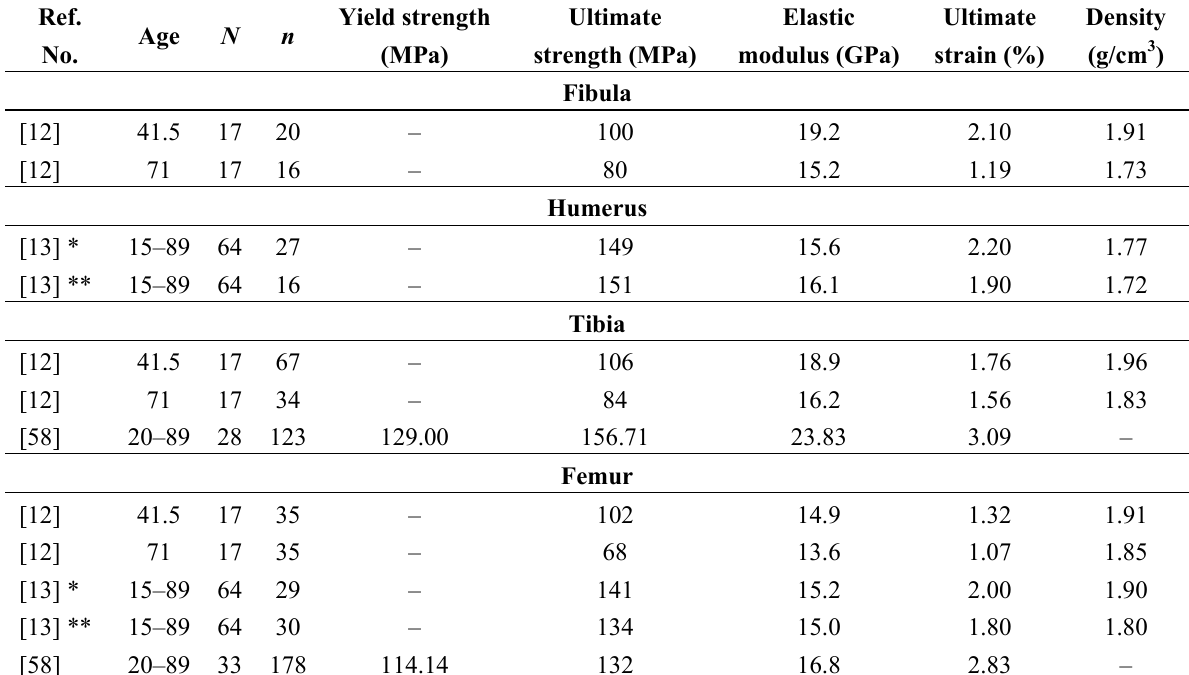
Table 1. Tensile properties of human cortical bone. ( N being the number of bones tested and n , the number of machined specimens obtained from them; *—male; **—female; 41.5